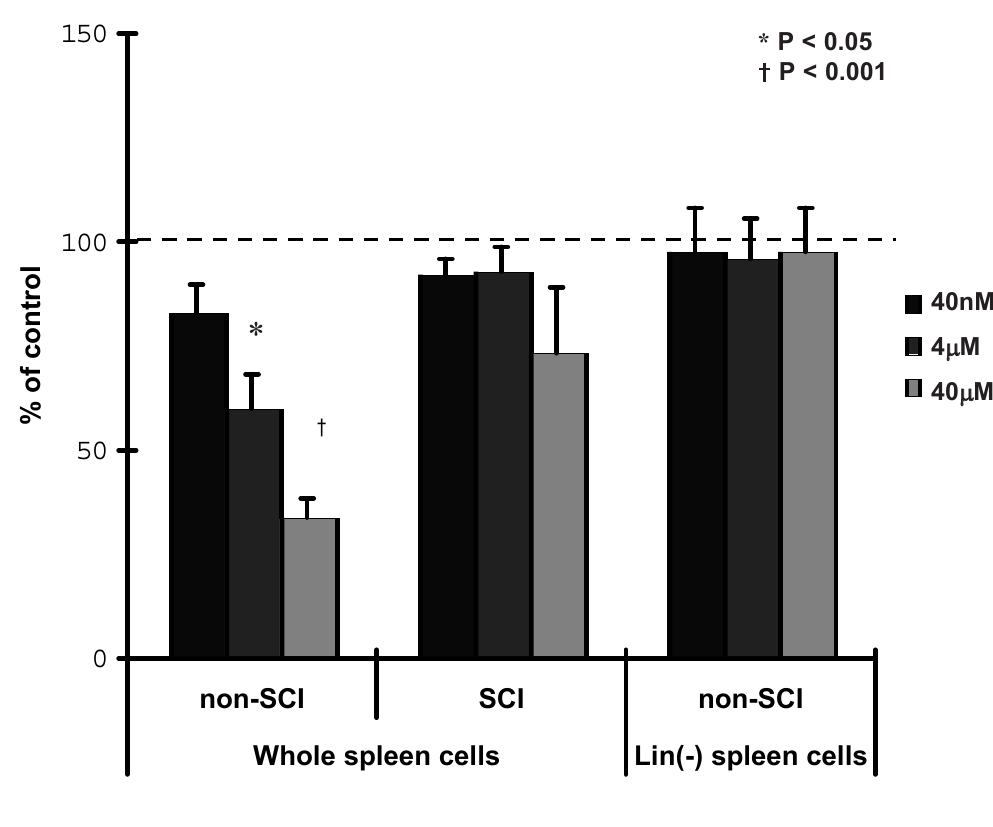
Figure 1.: CFU-mast colony formation of unfractionated spleen cells and Lin (-) spleen cells from young non- SCI and senescent SCI mice in the presence of neopterin. Unfractionated spleen cells (1x10 6 cells/dish) from non- SCI and SCI mouse or Lin(-) BMCs (1x10 5 cells/dish) from non-SCI were incubated in the soft agar culture sys- tem containing IL-3 with or without neopterin. The numbers of colonies were determined after 21 days. Each bar represents the mean ± SD obtained from tetra plicate experiments. The absolute number of CFU-mast colony in control (without neopterin treatment) cultures were, 134.6 ± 7.4/10 6 for non-SCI, 86.2 ± 4.0/10 6 for SCI and 50.7 ± 4.4/10 5 for Lin (-) spleen cells, respectively. ∗ , p <0.05, †, p <0.001 vs.